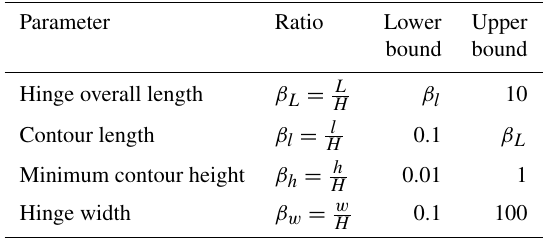
Table 1. Geometric flexure hinge parameters related to the total hinge height and their parameter